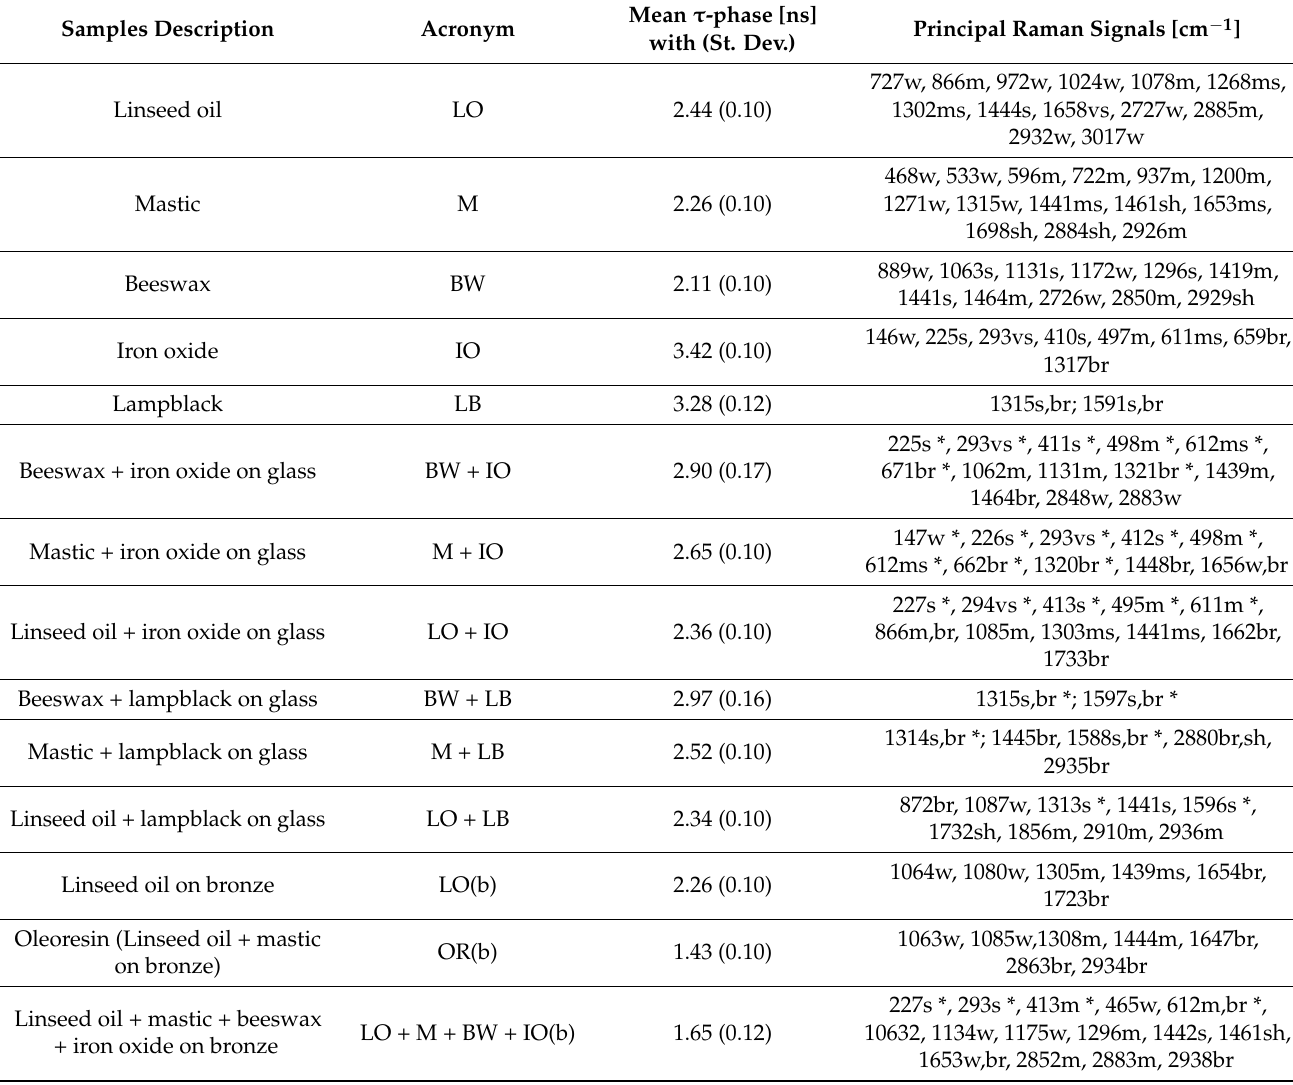
Table 1. List of the analyzed samples with mean τ -phase and main Raman